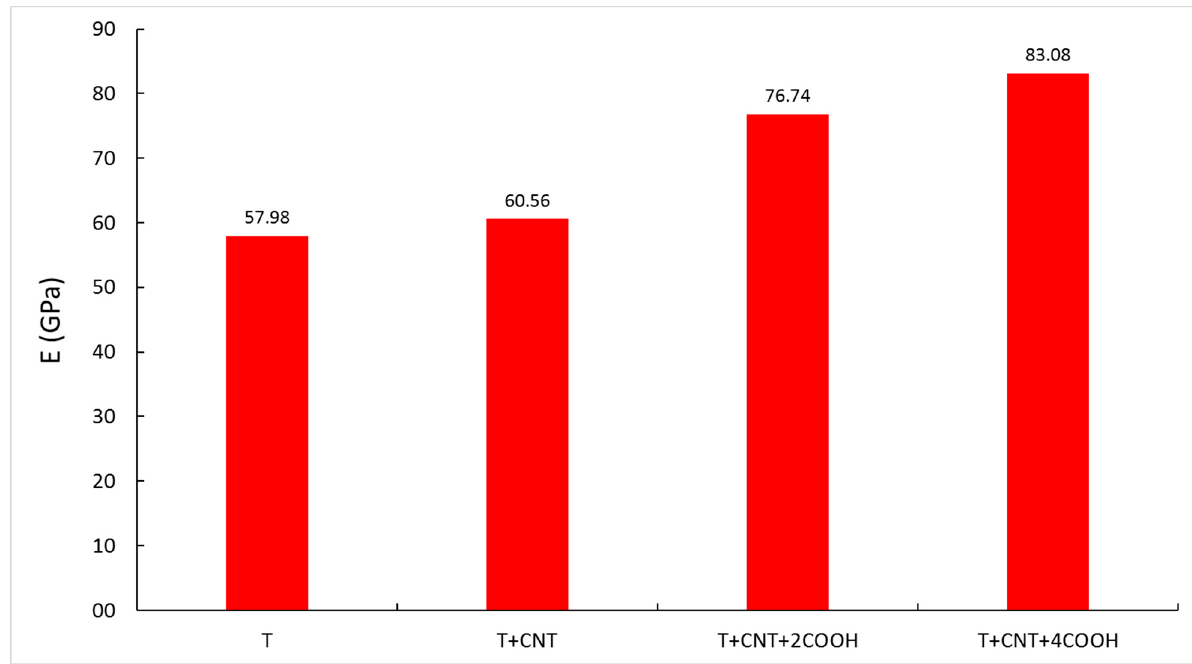
Figure 4. Young’s modulus for all models.